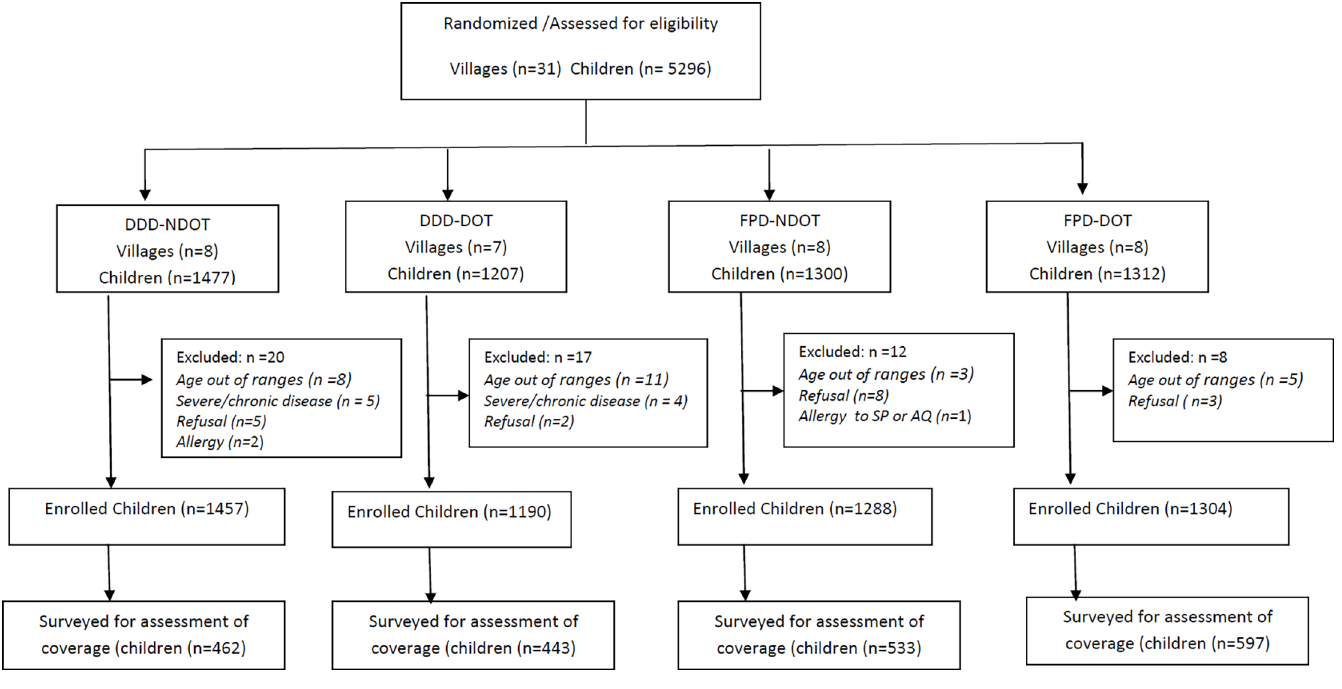
Fig 1. Flow diagram. https://doi.org/10.1371/journal.pone.0193296.g001 to the FPD method (Table 2). The inter cluster correlation coefficient was 0.09 (95% CI 0.03– 0.14). The proportions of children who did not receive any round of SMC and the proportions of children who received at least one or two rounds of SMC according to the method of delivery, are presented in Table 3. The proportion of children who did not receive any round of SMC was significantly lower (1.5%) in children who received SMC door to door compared to those who received SMC at a fixed point (5.8%, p < 0.01), while the proportion of children who received at least two rounds of SMC was significantly higher with the DDD method compared to the FPD method (93.9% versus 84.2%, p < 0.01) (Table 3).